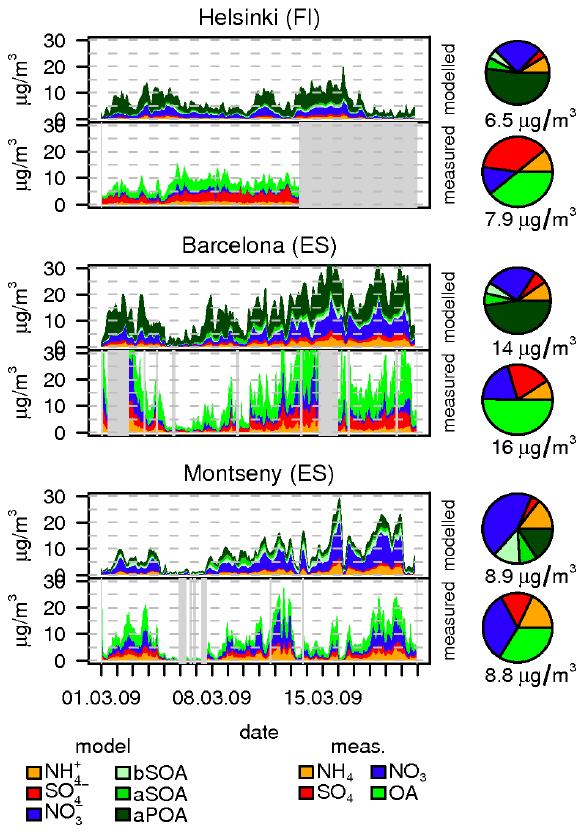
Fig. 10b. Timeline of aerosol chemical composition as done in Fig. 9 but for stations measuring during the spring 2009 period (2 of 2).